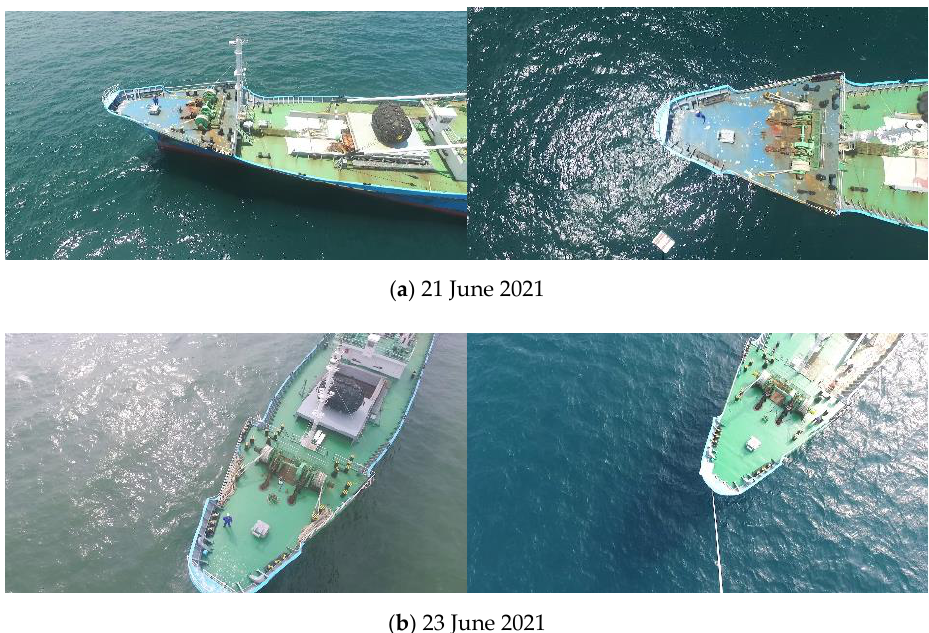
Figure 2. Case of SUAH_Reefer Paint Color Change in the Southern Outer Anchorage of Busan Port.